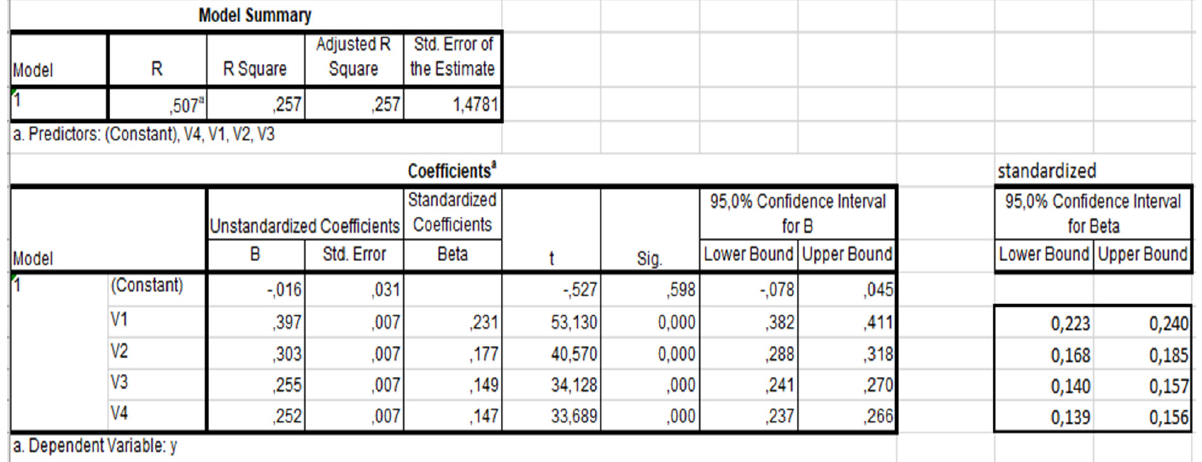
Figure 2. The multiple regression results with